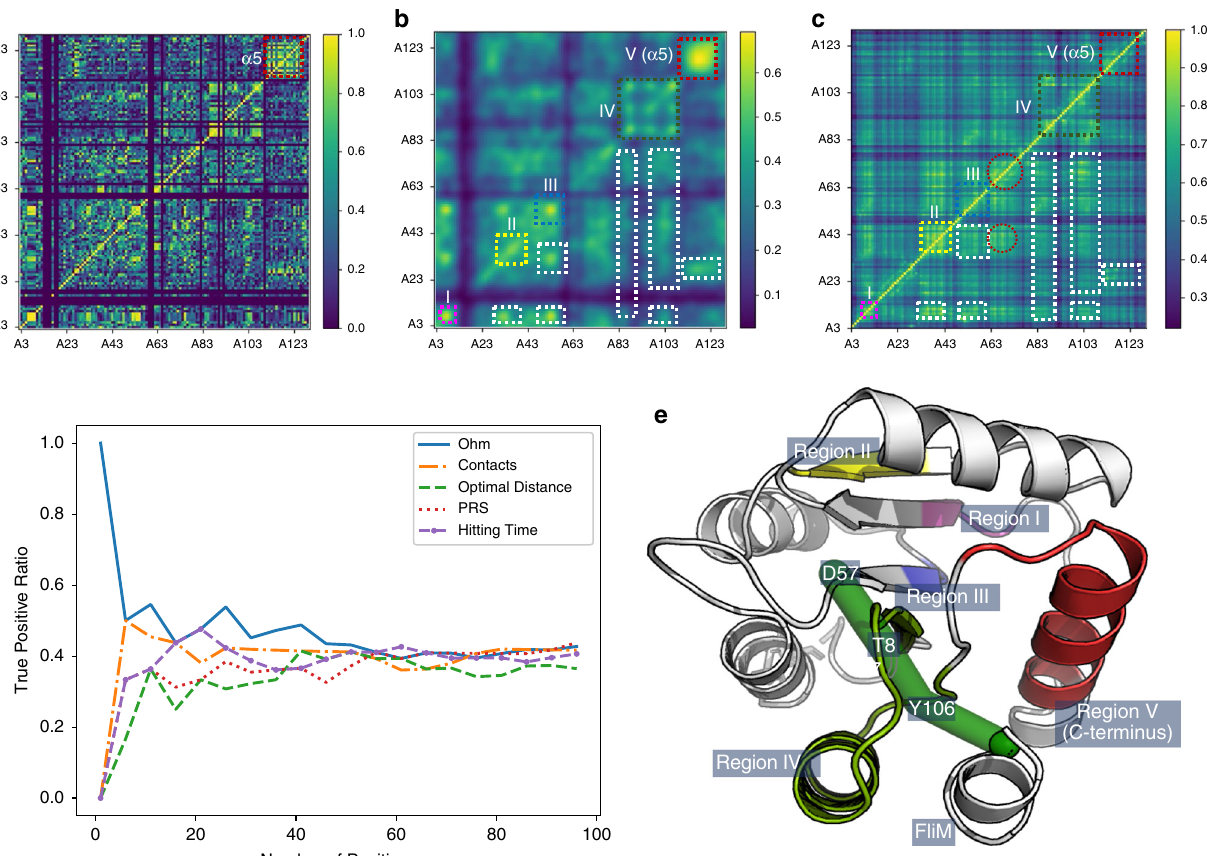
Fig. 5 Comparison of allosteric correlations measured by CHESCA and predicted by Ohm. a Allosteric correlations measured by CHESCA. Blank rows and columns are caused by missing data for residues 1, 2, 13, 14, 15, 16, 18, 19, 59, 60, 61, 65, 82, 90, 92, and 110. CHESCA data are in Supplementary Data 1. b Allosteric correlations measured by CHESCA subjected to Gaussian fi ltration. Dashed boxes, including the colored boxes (I, II, III, IV, and V) and the white boxes, are common regions to CHESCA and Ohm analysis. c Allosteric correlations predicted by Ohm. Regions in dashed circles only appear in allosteric correlations predicted by Ohm. d The true-positive ratio of allosteric correlations predicted by Ohm, native contacts, the shortest paths lengths, PRS, and the hitting time. Data of all methods for the comparison can be found in Supplementary Data 3. e Tertiary structure of CheY Regions indicated in panels b and e are labeled. The green cylinders represent the allosteric